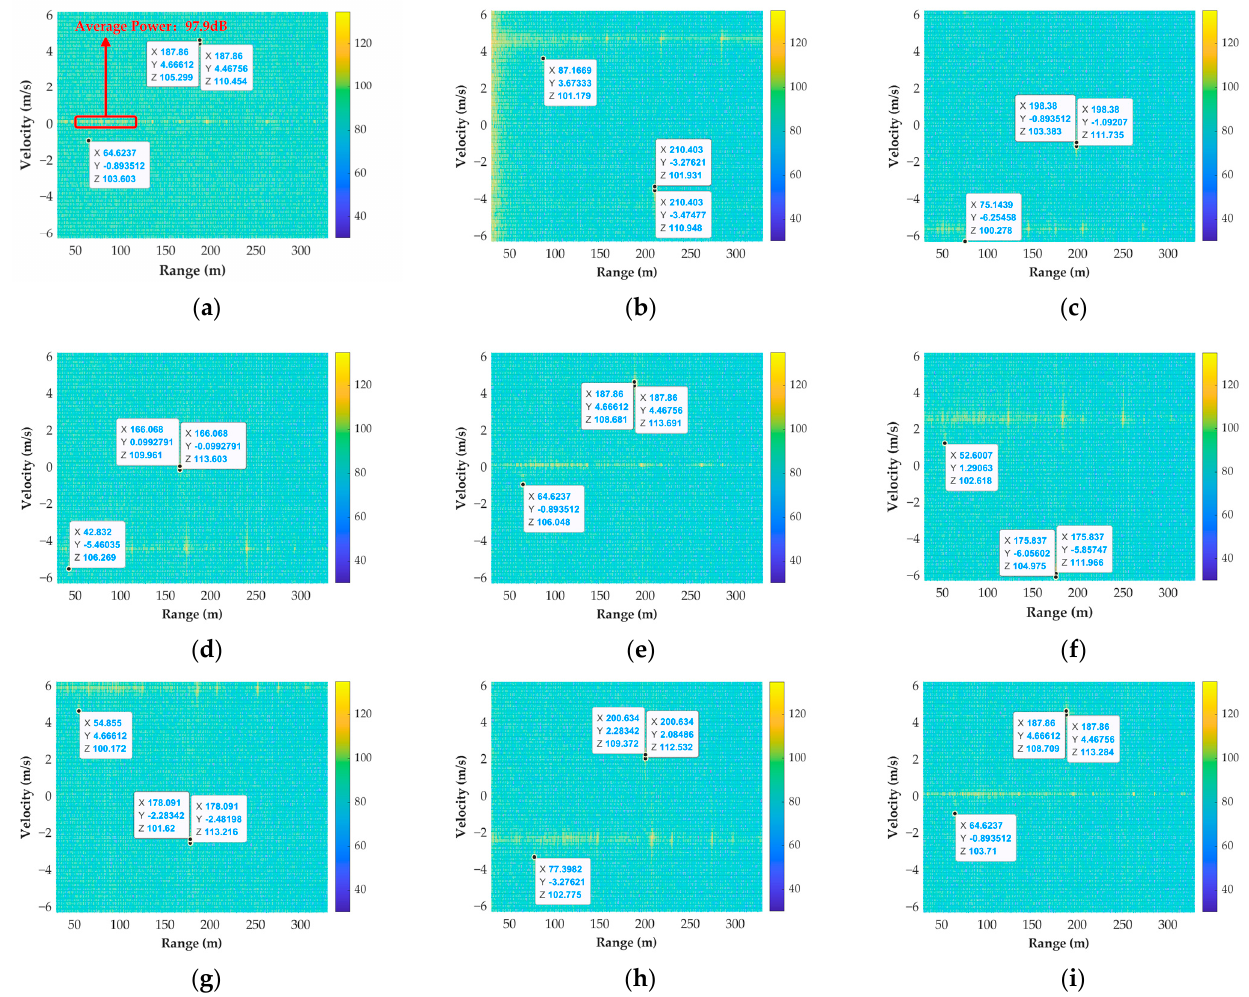
Figure 18. The range–Doppler spectra of multi-channel with real data. ( a – i ) are the channels 1T1R to 3T3R, respectively.